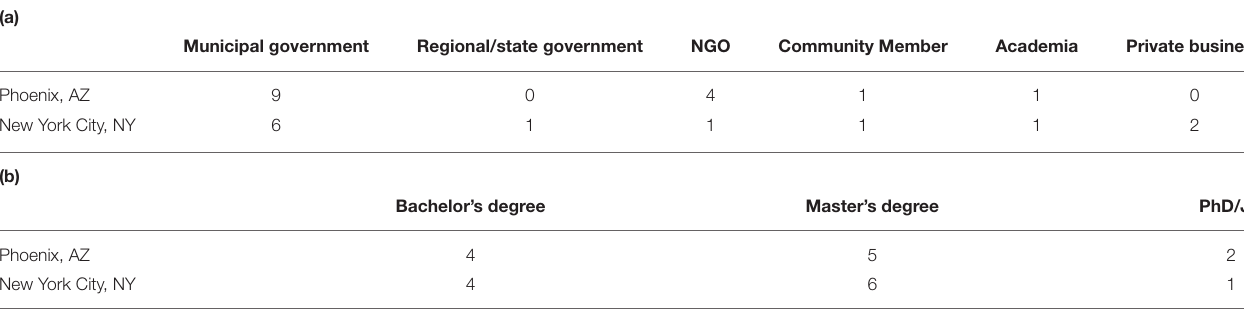
TABLE 3 | Breakdown of participant characteristics by (a) sector * and (b) highest level of education attained. (a)